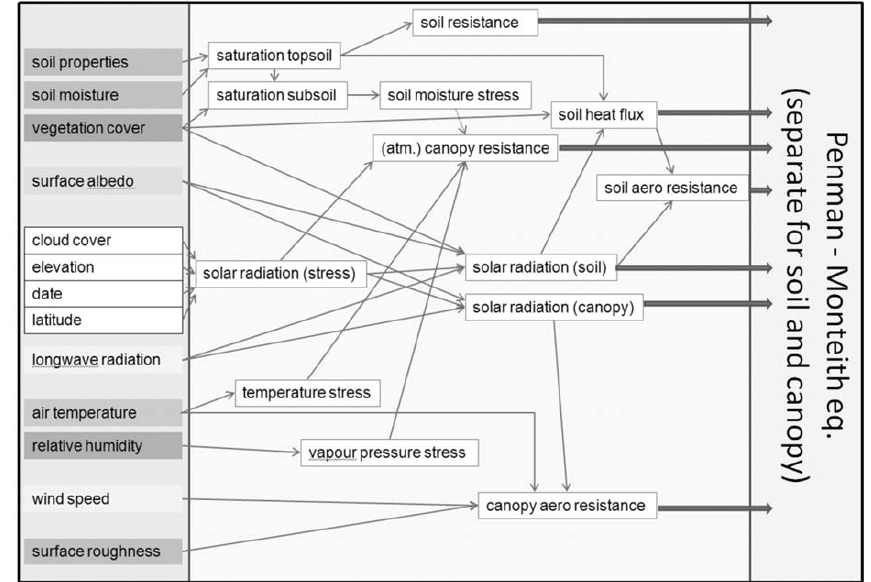
Fig. 3. Schematic flowchart of